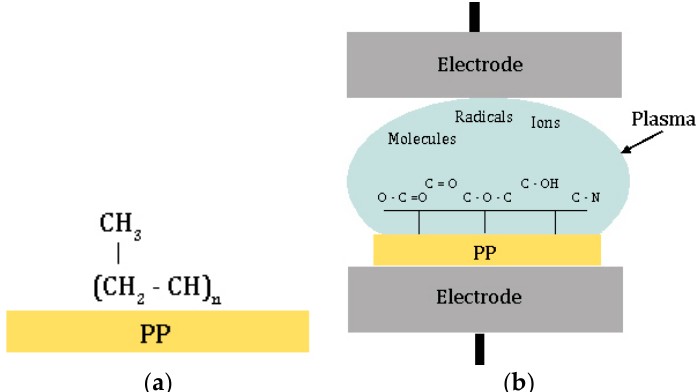
Figure 1. Scheme of the low-pressure glow discharge plasma (LPP) surface modification: ( a ) Polypropylene (PP) base composition, ( b ) possible polar groups introduced in the outer most layers of the surface by reactions with plasma species (mainly radicals, ions and molecules).